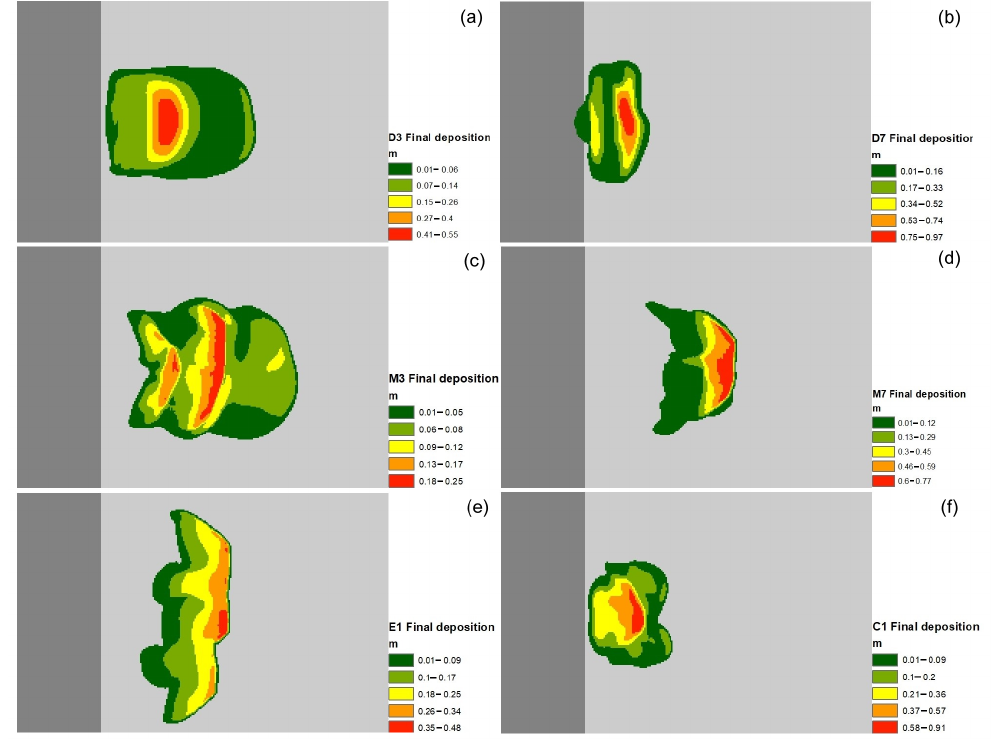
Figure 11. Final deposition height in ( a ) D3; ( b ) D7; ( c ) M3; ( d ) M7; ( e ) E1; ( f )